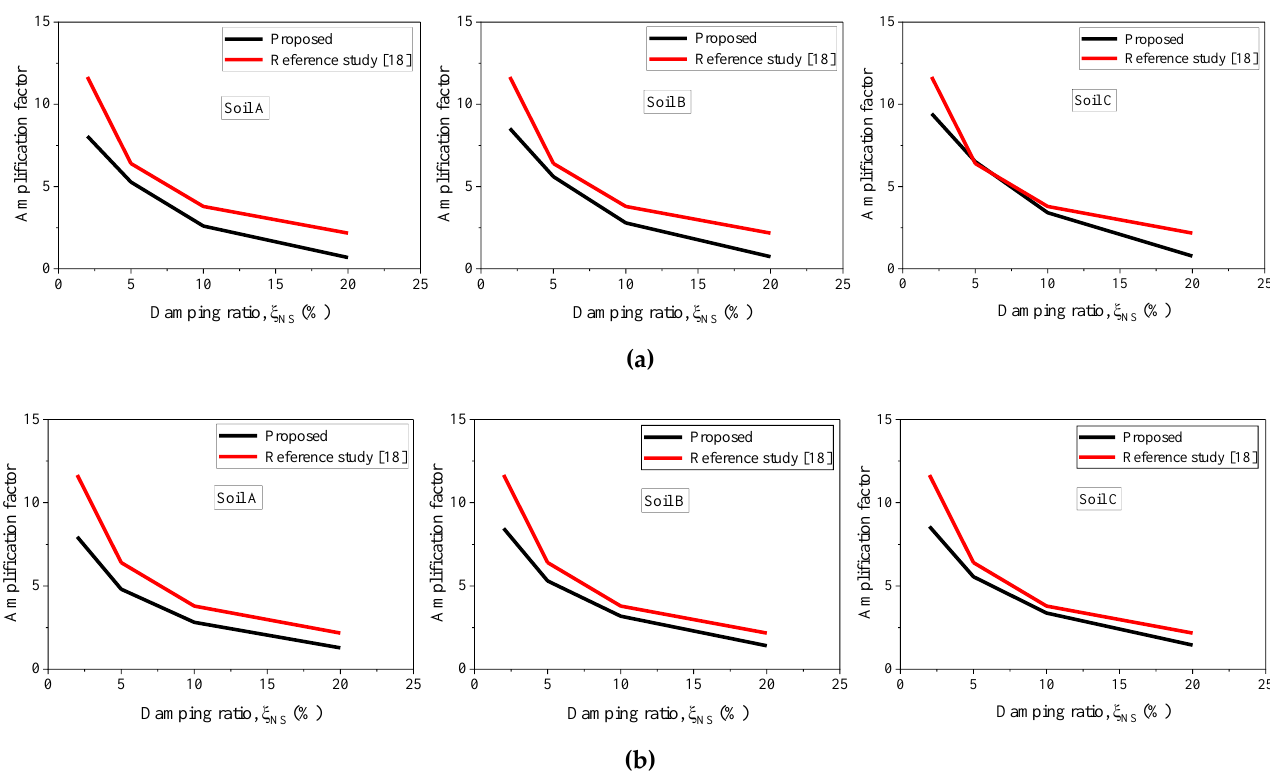
Figure 20. Comparison of amplification factors: ( a ) regular model; ( b ) irregular model.